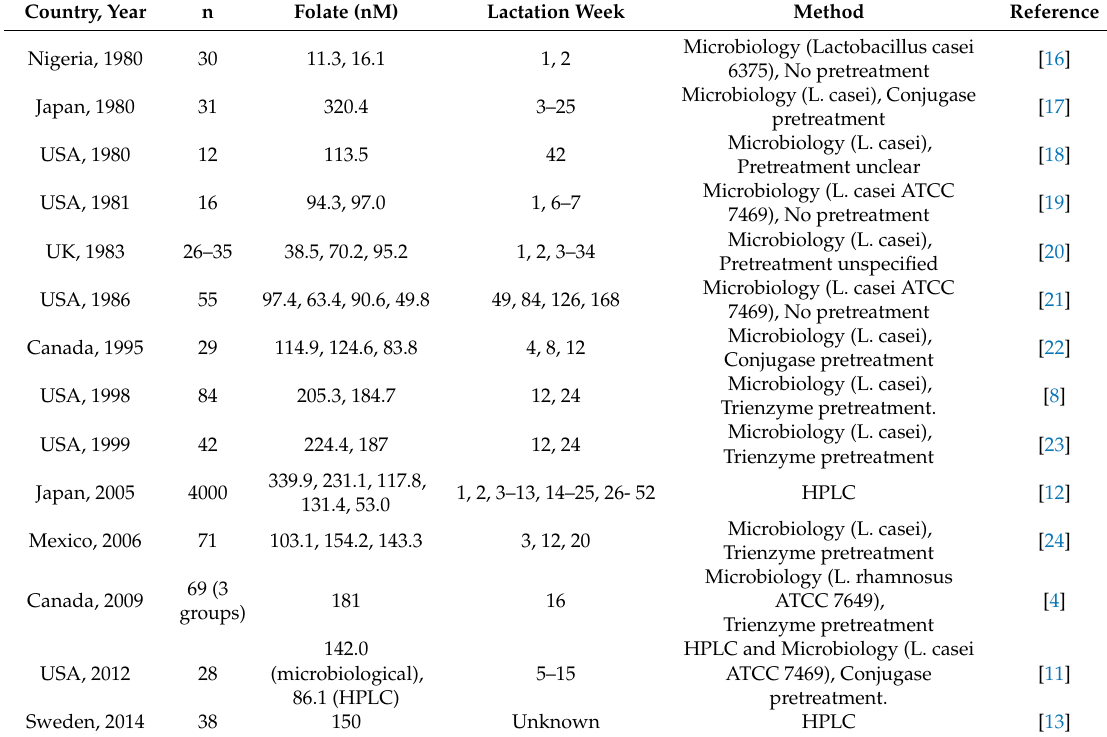
Table 3. Overview of reported values of breast milk folate in a variety of cohorts, determined with microbiology- or chromatography-based